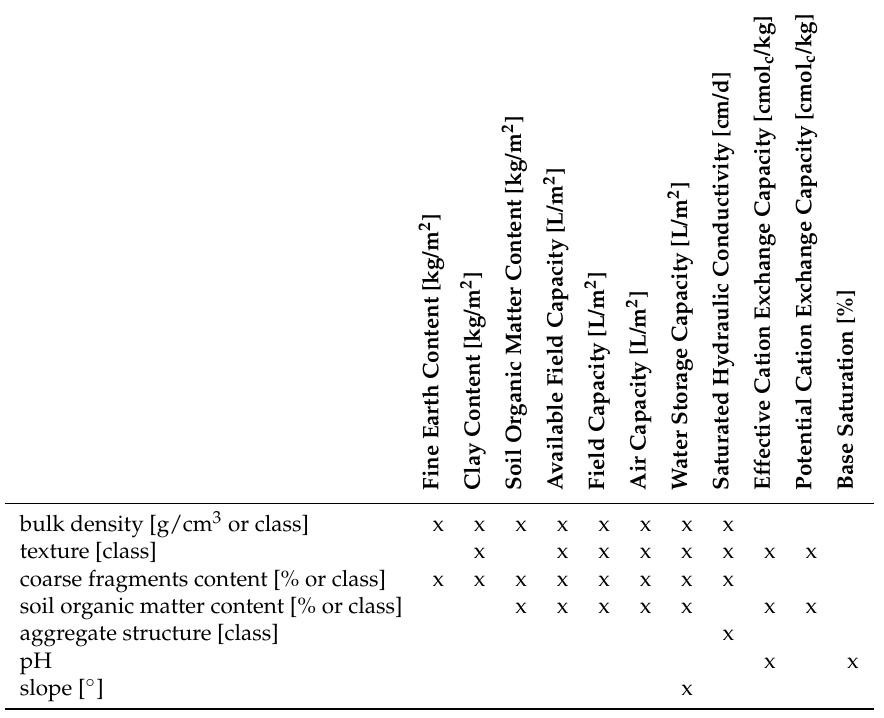
Table 2. Overview of the soil parameters parameters (rows) which are used in pedotransfer functions to compute the complex parameters per soil horizon